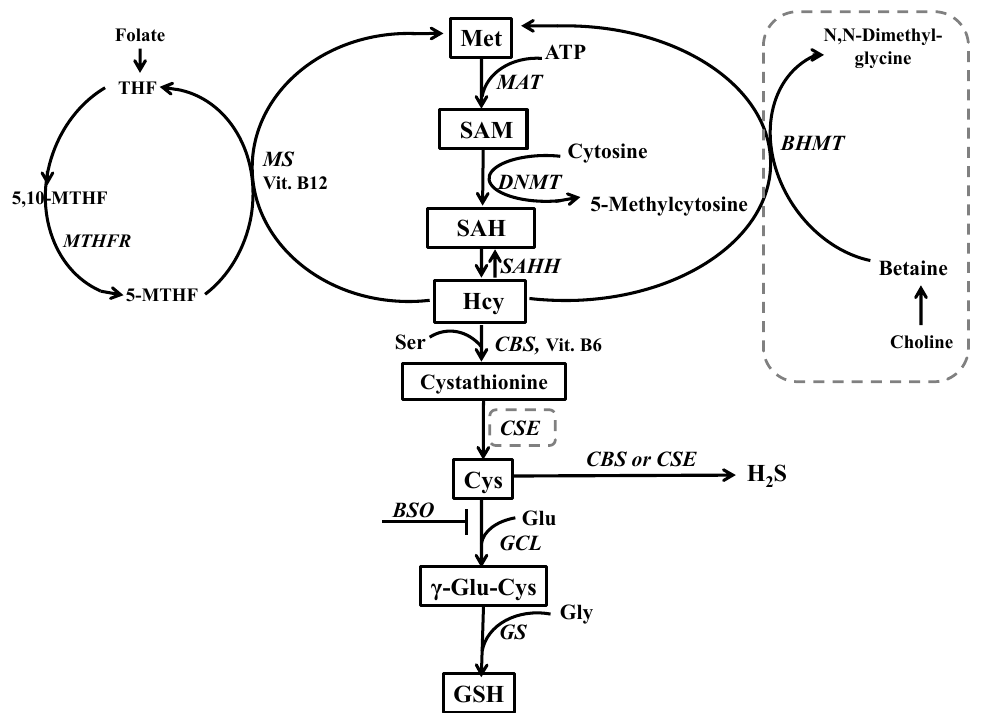
Figure 10. Hepatic metabolic pathways of Met. In the liver, dietary Met is activated by conversion to SAM in an ATP-dependent reaction catalyzed by methionine adenosyltransferase (MAT) SAM (approximately 98%) is preferentially used as a donor of methyl groups for different methyltransferases that transfer them to a variety of acceptor substrates (nucleic acids, proteins, phospholipids, and neurotransmitters) with the simultaneous formation of S-adenosylhomocysteine (SAH) that is further hydrolyzed, by S-adenosylhomocysteine hydrolase (SAHH) to yield Hcy and adenosine. The latter reaction is readily reversible and may cause a chronic elevation of Hcy level. Under normal conditions, Hcy can be either converted into cystathionine by the transsulfuration pathway or used again for the synthesis of Met. Cystathionine is converted to Cys via metabolic reactions mediated by cystathionine β -synthase (CBS) and cystathionine γ -lyase (CSE), consecutively. In the liver, there are two separate remethylation reactions catalyzed by betaine homocysteine methyltransferase (BHMT) and methionine synthase (MS). In the liver, methyl groups used for Hcy re-methylation are provided by both methyl tetrahydrofolate (MTHF) and by the oxidative metabolite of choline, betaine, whereas in other tissues only MTHF is used as a donor of methyl group for MS. The dashed line indicates the lack or weak expression of a given enzyme in the brain.